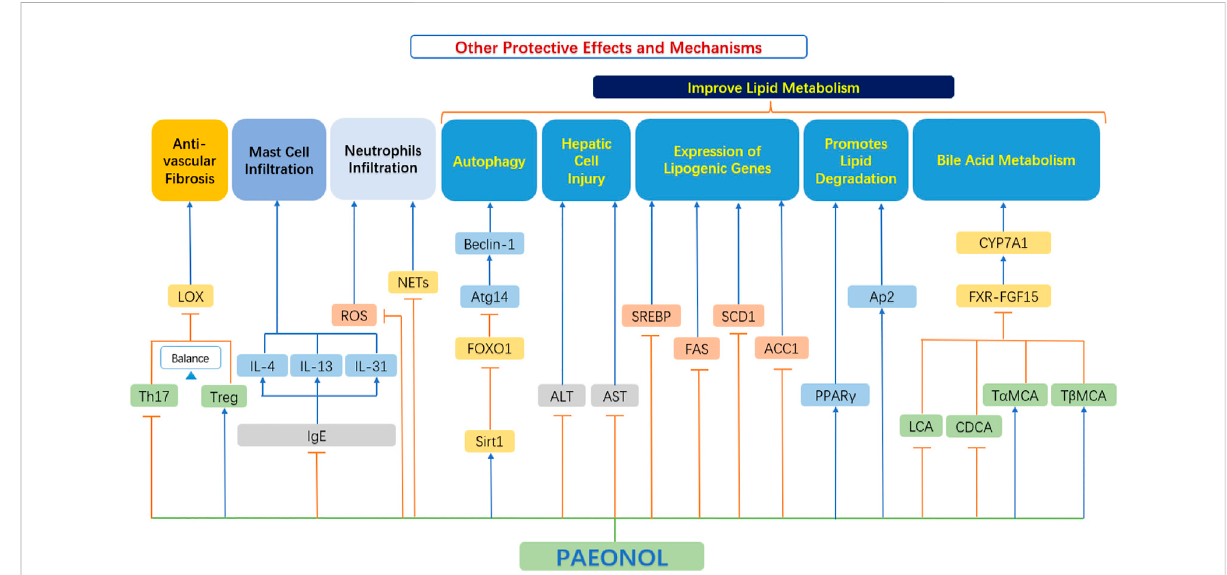
FIGURE 8 Other protective effects and mechanisms of paeonol. ACC1, acetyl-CoA carboxylase-1; ALT, alanine aminotransferase; Ap2, adipocyte protein 2; AST, aspartate aminotransferase; Atg14, autophagy related 14; Beclin-1, the mammalian ortholog of yeast ATG6; CDCA, chenodeoxycholic acid; CYP7A1, cholesterol 7 α -hydroxylase; FAS, fatty acid synthase; FOXO1, forkhead box transcription factor O1; FXR, farnesoid X receptor; FGF15, fi broblast growth factor 15; IgE, immunoglobulin E; IL-4, interleukin 4; IL-13, interleukin 13; IL-31, interleukin 31; LOX, lysyl oxidase; NETs, neutrophilsextracellular traps; PPAR- γ , peroxisome proliferator-activated receptor γ ;ROS, reactive oxygen species; SCD1, stearoyl-CoA desaturase 1;Sirt1,sirtuin1;SREBP,sterolregulatoryelement-bindingprotein;T α MCA,tauro- α -muricholicacid;T β MCA,tauro- β -muricholicacid;Th17,Thelper type 17 cell; Treg, Regulatory